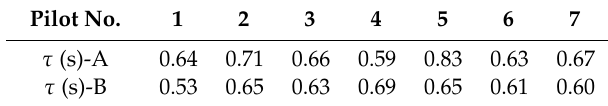
Table 1. Mean values of pilots’ reaction delay τ (A—the first testing set; B—the second testing set). Pilot No.